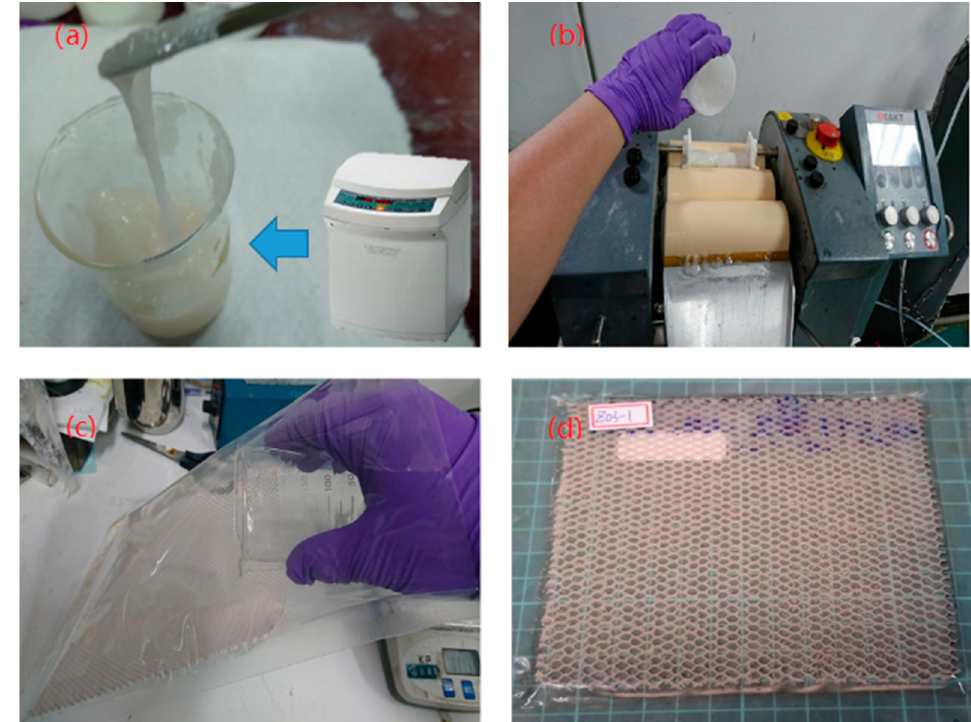
Figure 1. Fabrication of STF-filled paper honeycomb. ( a ) planetary mixer ( b ) three-roller mixer ( c ) Filled with good flowing STF into honeycomb paper ( d ) Schematic diagram of STF structure.